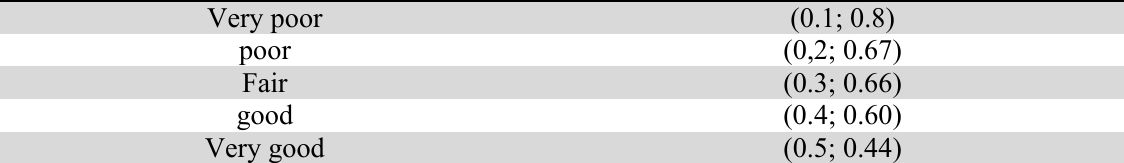
Definitions of linguistic variables for the ratings